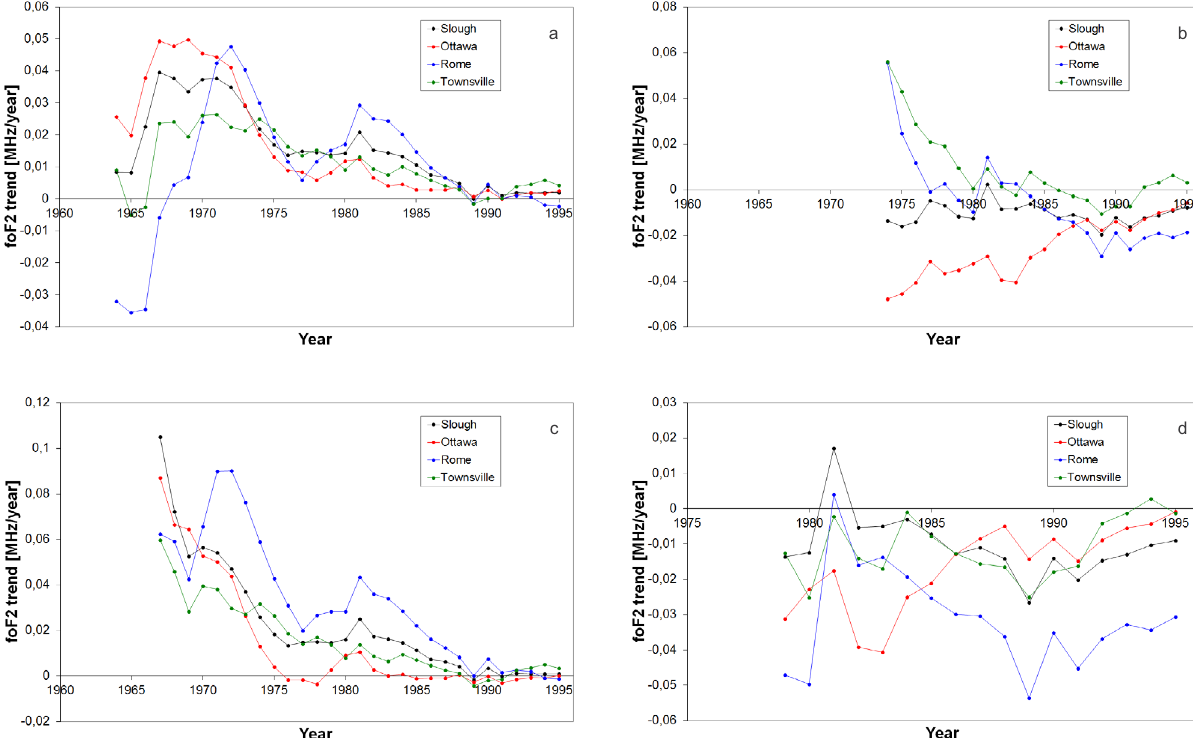
Figure 3. foF2 trend estimated for foF2 residual time series starting during (a) 1954 solar minimum, (b) 1964 solar minimum, (c) 1957 solar maximum, and (d) 1969 solar maxim considering the first 10 years and then adding the following year for a new data and adding one year at a time. The year corresponding to each trend value is the final year considered for trend